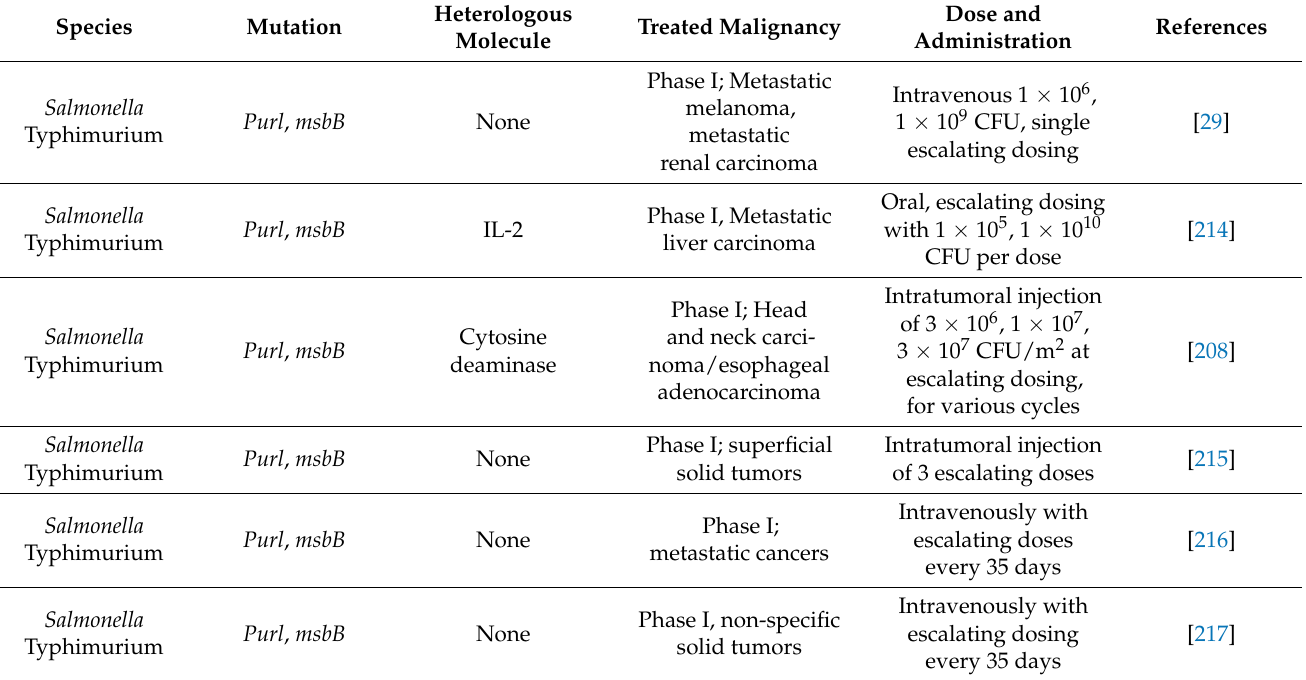
Table 3. Clinical trials using Salmonella enterica as cancer